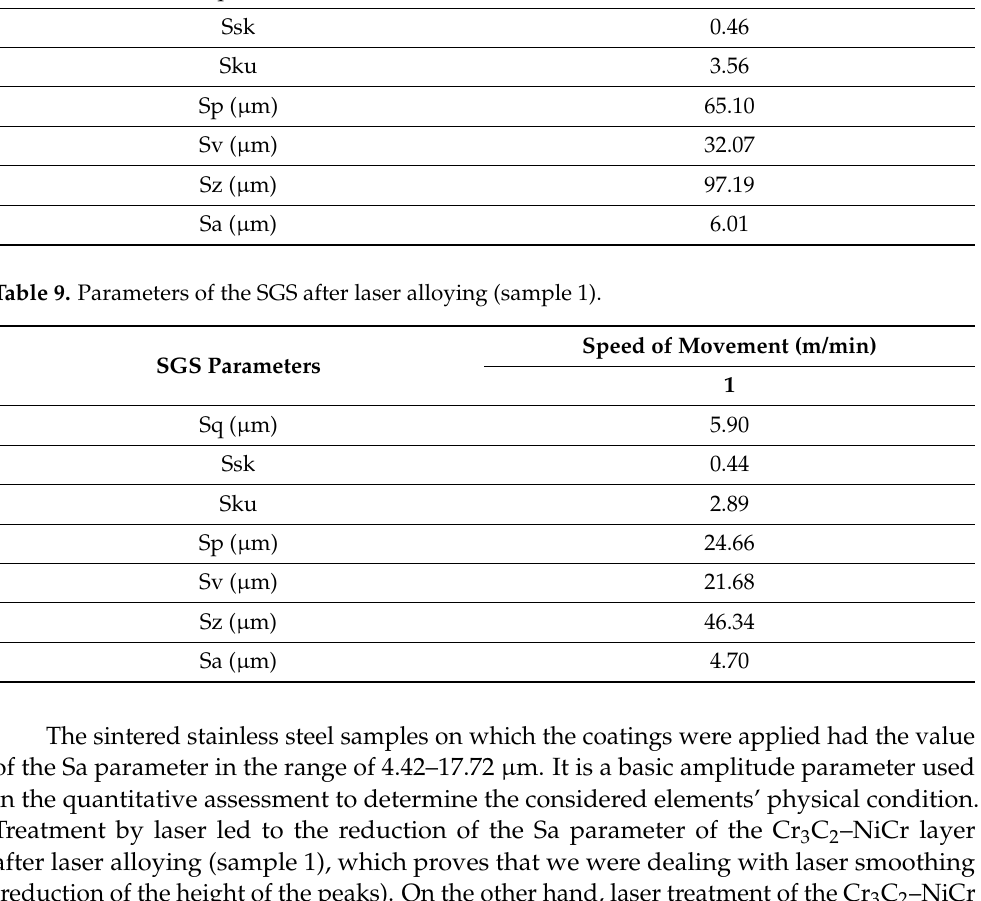
Table 8. Parameters of the SGS of the Cr 3 C 2 –NiCr coating.